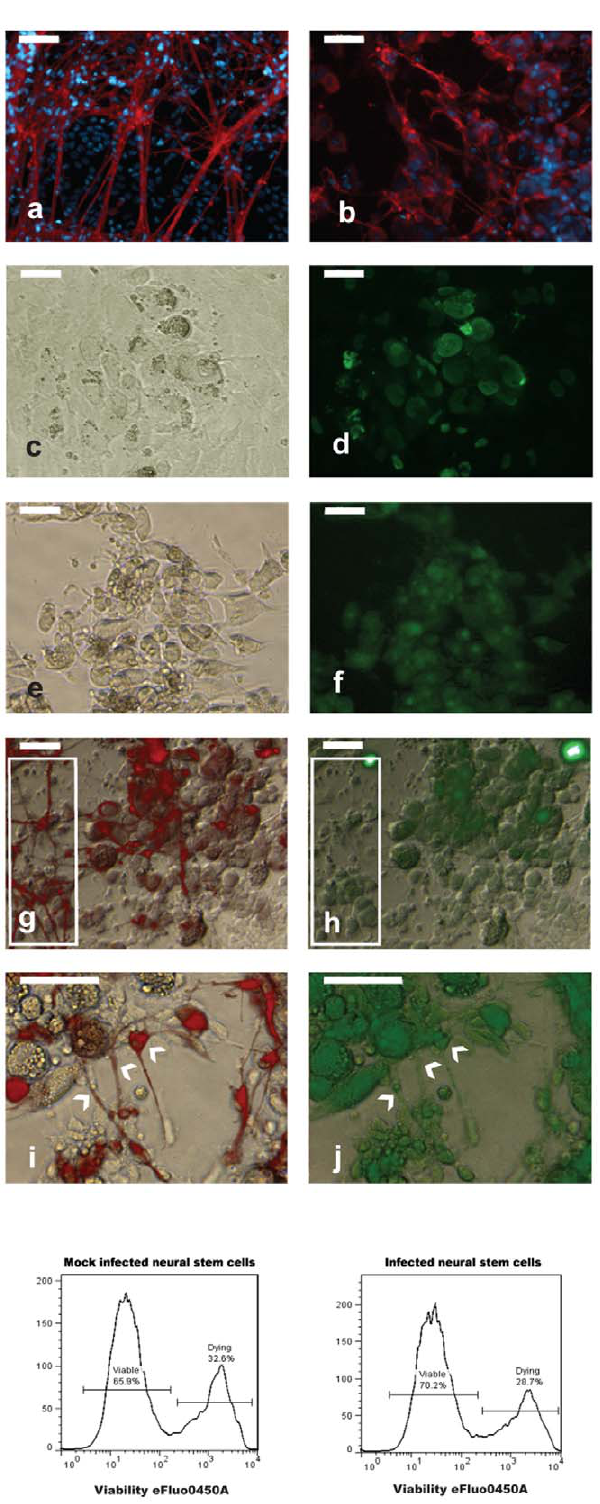
Figure 3. Effect of HCMV on differentiation of neural rosettes. Top panel . Identification of neurons differentiating in mock infected (a) and infected (b) cultures by Tuj 1 immnostaining (red). The presence of HCMV antigens in infected cells displaying CPE (c, e) was determined by staining for pp65 (d) and blend (f, see material and methods). (g–j): Analysis of neurons differentiating from infected neural rosettes. Co- immunostaining for Tuj1 (red) and pp65 (green) showed that